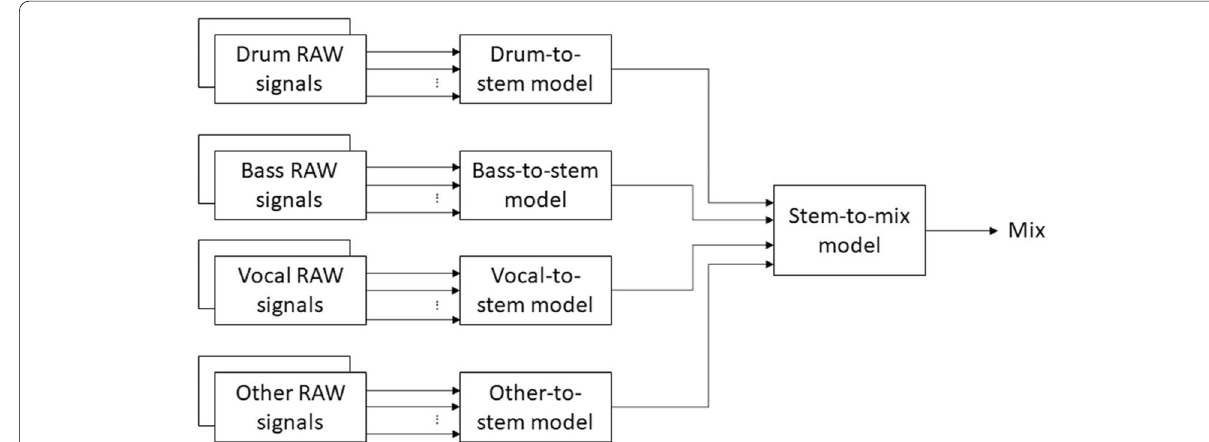
Fig. 1 Block diagram of an automatic audio mixing system